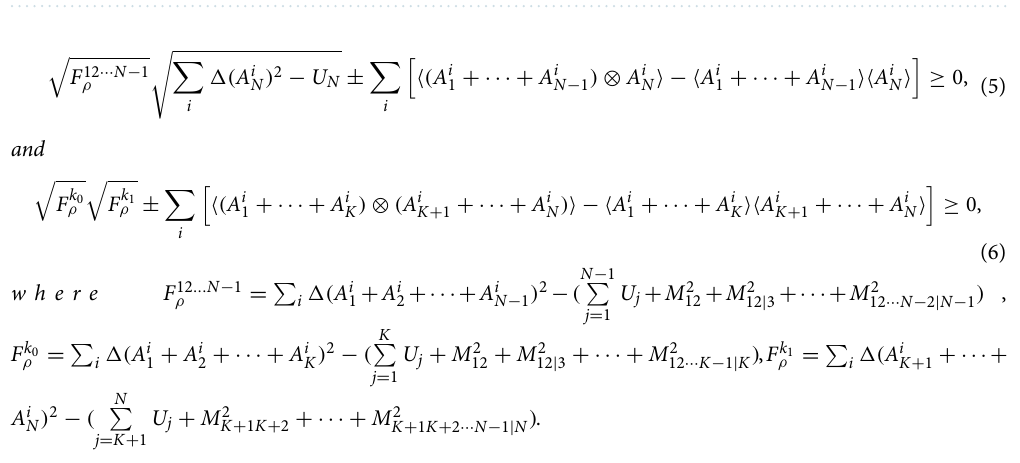
Figure 4. For the four-partite Dicke state D 4 2 mixed with the white noise ρ 2 . The the black line stands for Tr (ρ W ) in Ref. 27 . By using the witness W , we can see that ρ 2 is entangled for p